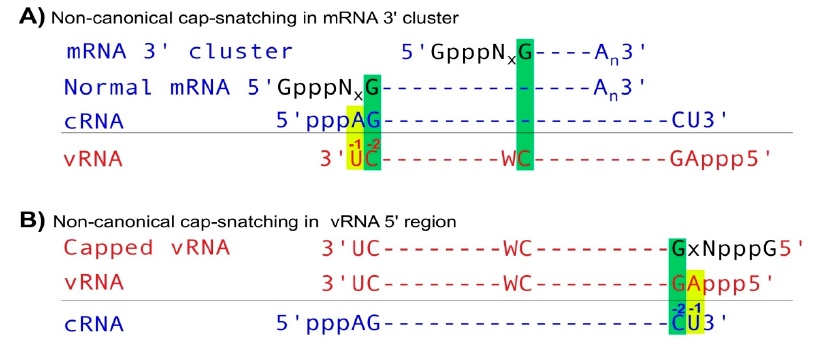
Figure 2. Noncanonical cap-snatching. ( A ) In mRNA 3 ′ clusters, IAV mRNA transcription starts using the basepairing of between the -1 nt (G) of host capped small RNAs and an internal nt C embedded in a 5 ′ CW (W represents A or U) sequence on template vRNAs. ( B ) In vRNA 5 ′ regions, IAV RdRP utilizes the -1 nt (G) of host capped small RNAs to anneal with the -2 C of template cRNAs, initiating capped vRNA synthesis.